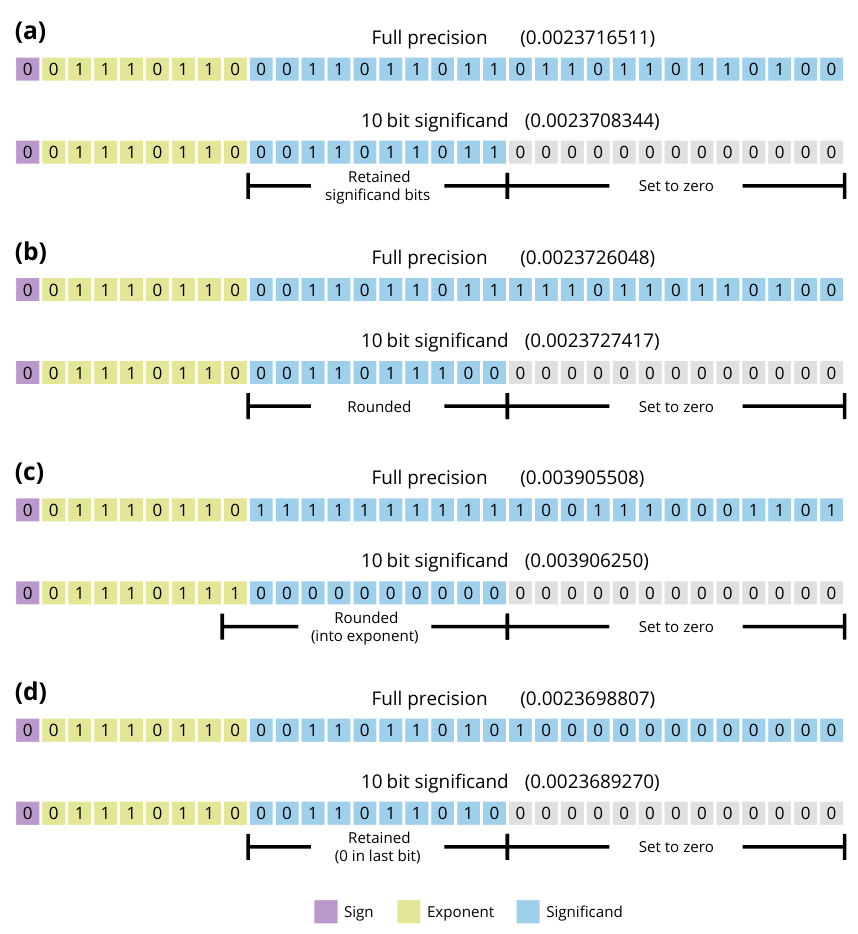
Figure 3. Examples of different rounding scenarios when truncating 32bit floating-point numbers to 10 significand bits. (a) Bit 13 (counted from the right; the left-most bit being truncated) is a 0; therefore, no rounding is necessary. (b) Bit 13 is a 1 which triggers rounding. (c) Bit 13 is a 1 which triggers rounding; in this case, the rounding reaches the exponent, which is permitted by IEEE 754. (d) The number is exactly halfway between two 10bit significand representations; this is a special case in IEEE 754 and always results in rounding to the representation with a 0 in the least significant